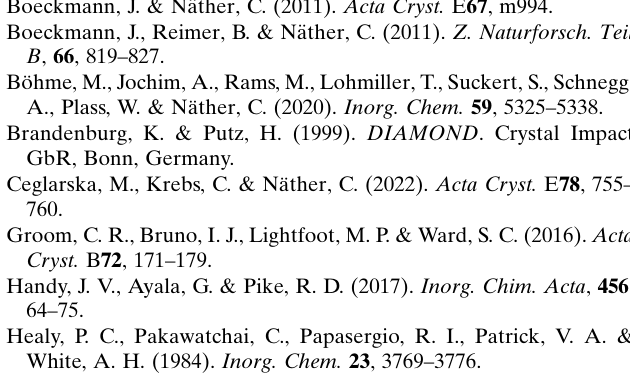
Crystal data Chemical